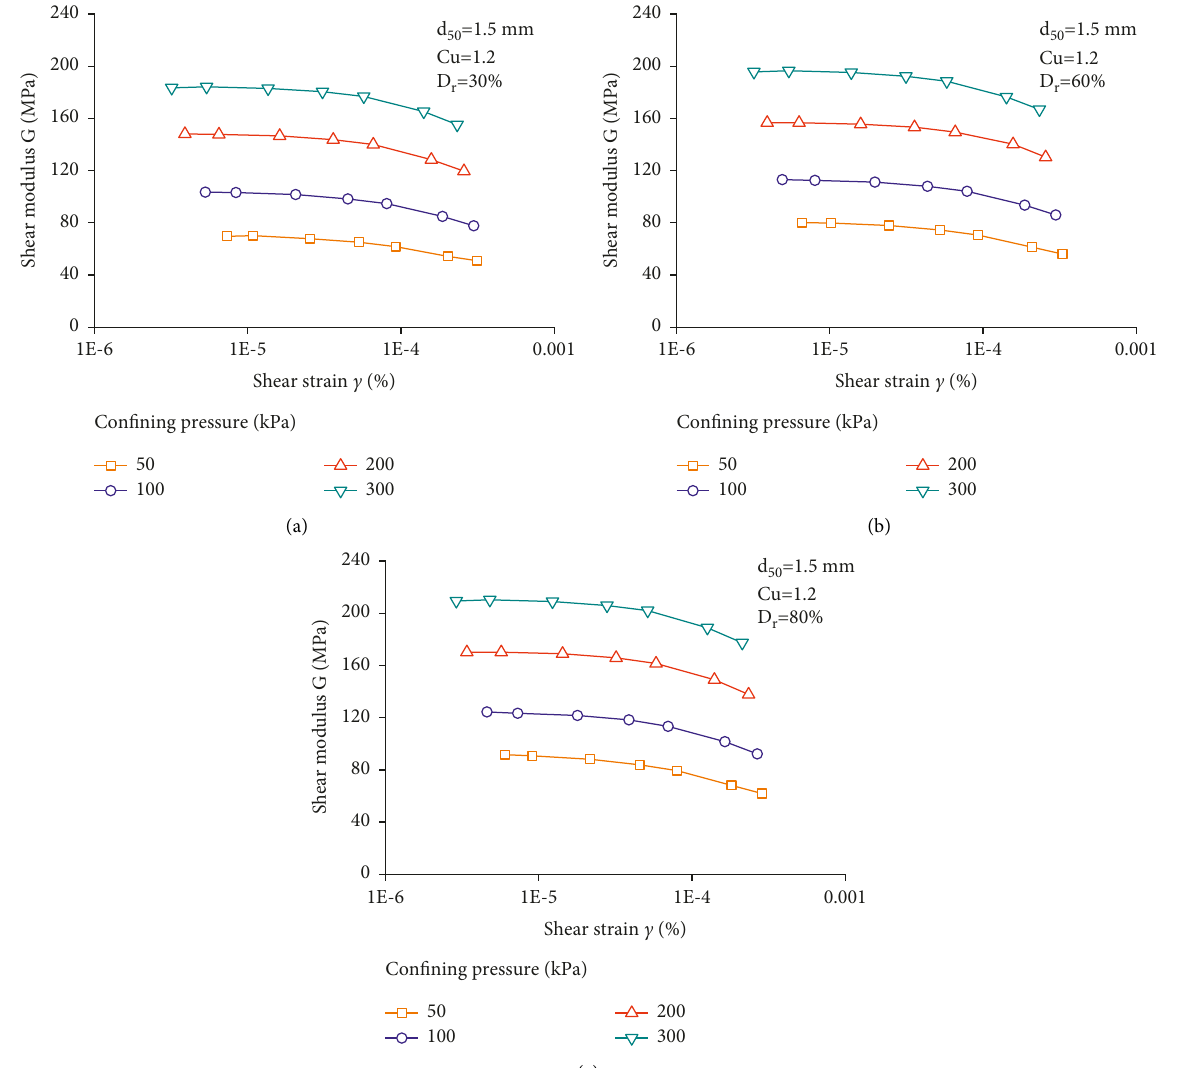
Figure 4: Shear modulus G and shear strain c for calcareous sand with d state. (b) Medium dense state. (c) Dense